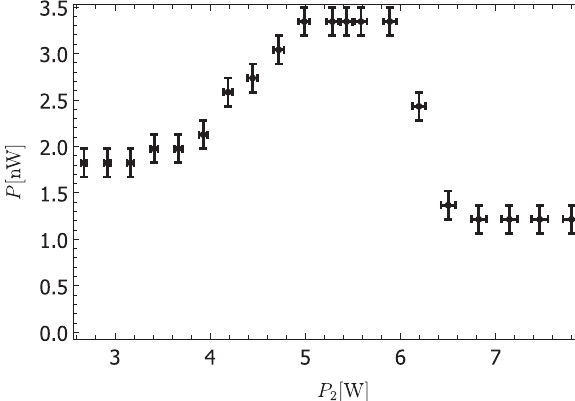
FIG. 10. SPR power P vs. power of the second-harmonic buncher cavity P 2 at the smallest grating period D ¼ 0 . 75